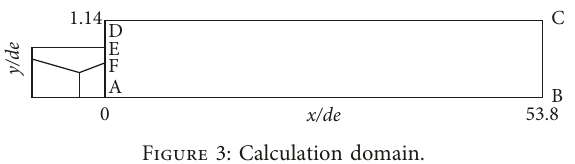
Figure 3: Calculation